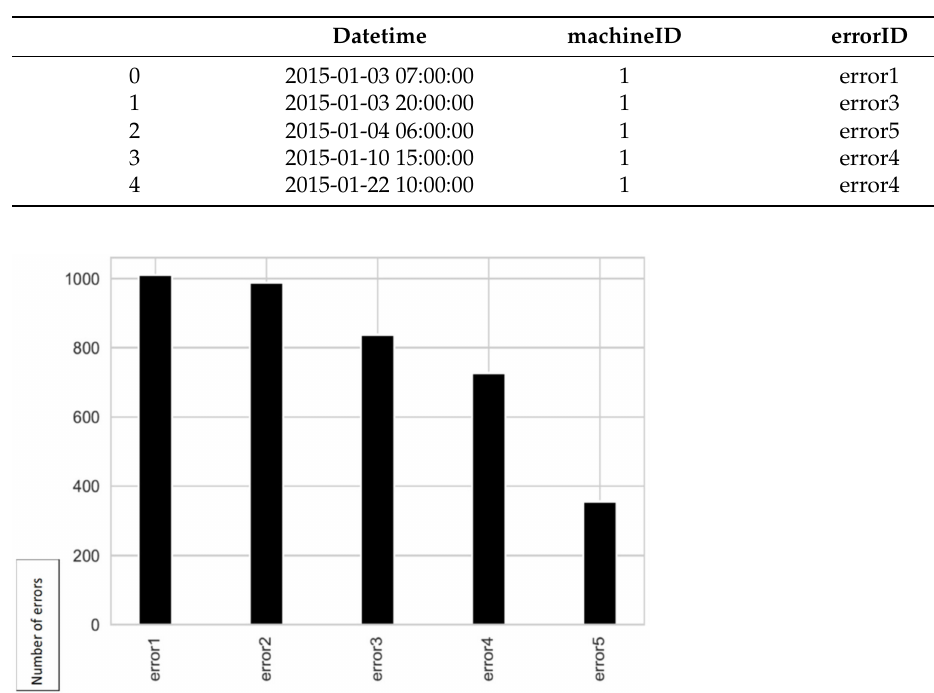
Table 3. Typical error logging example.